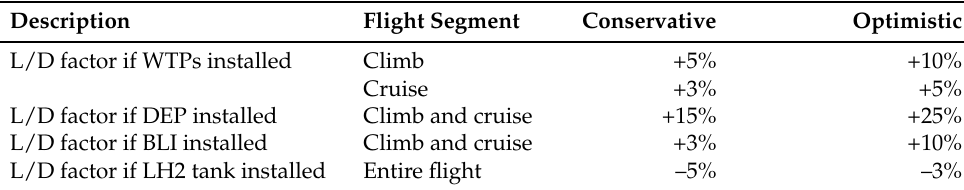
Table 4. Assumption on glide ratio improvements for selected novel propulsion technologies during various flight